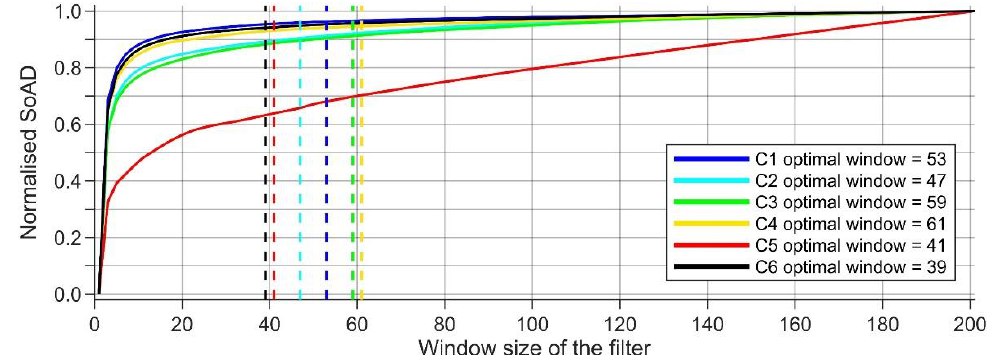
Figure 9. Sum of absolute difference (SoAD) functions for the marine survey campaigns. Optimal filtering window sizes are shown with dashed vertical lines.